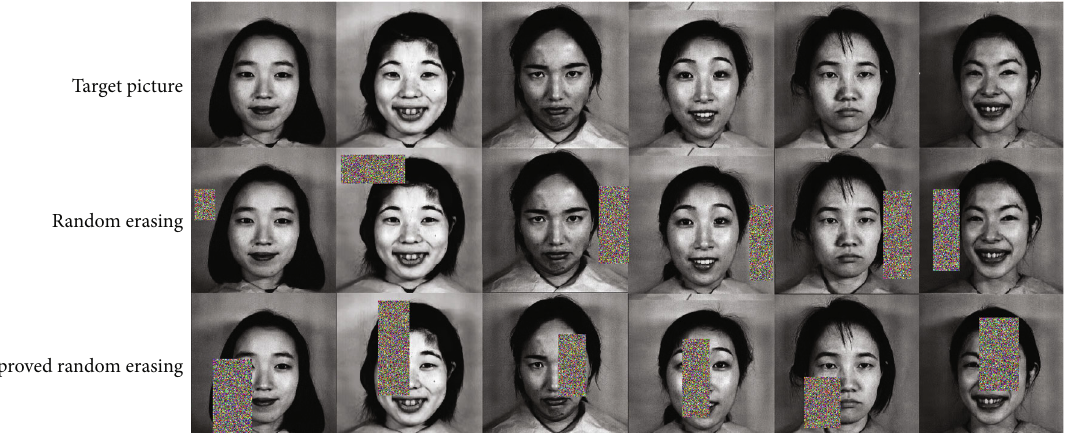
Figure 5: Comparison chart of the random erasing experiment.